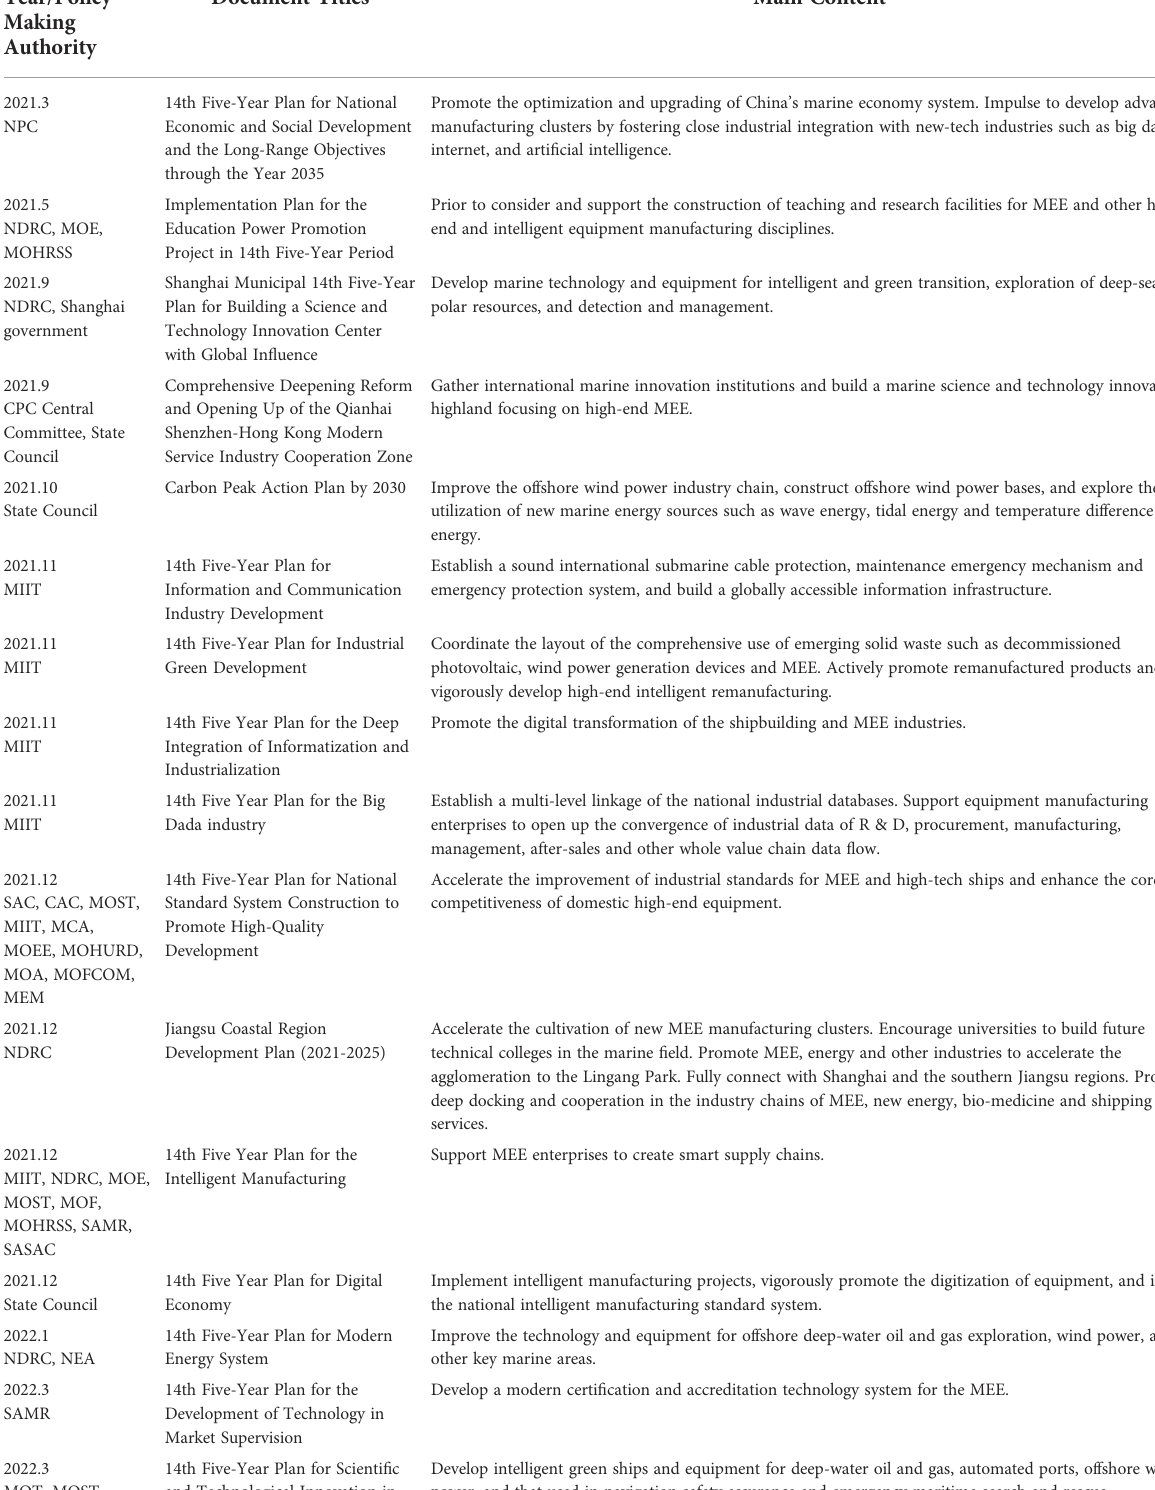
TABLE 2 The 14th Five-Year Plans issued by the central governmental